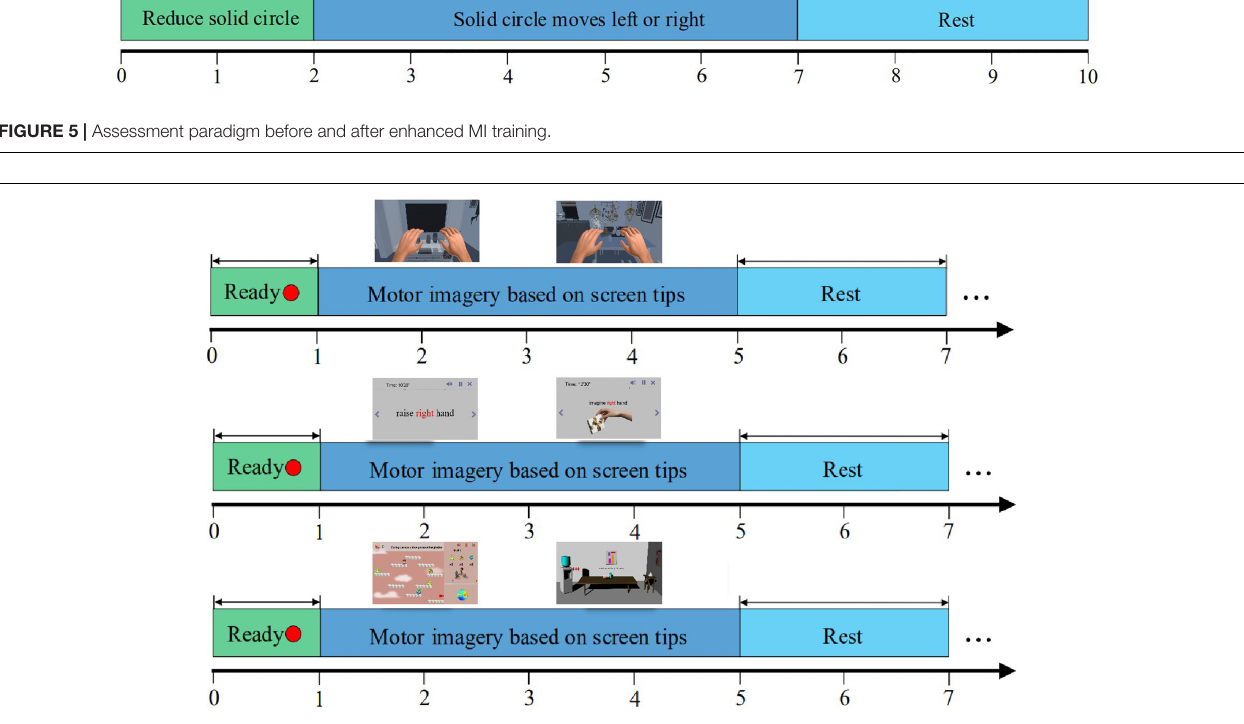
FIGURE 6 | Experimental paradigm of enhanced MI training in different